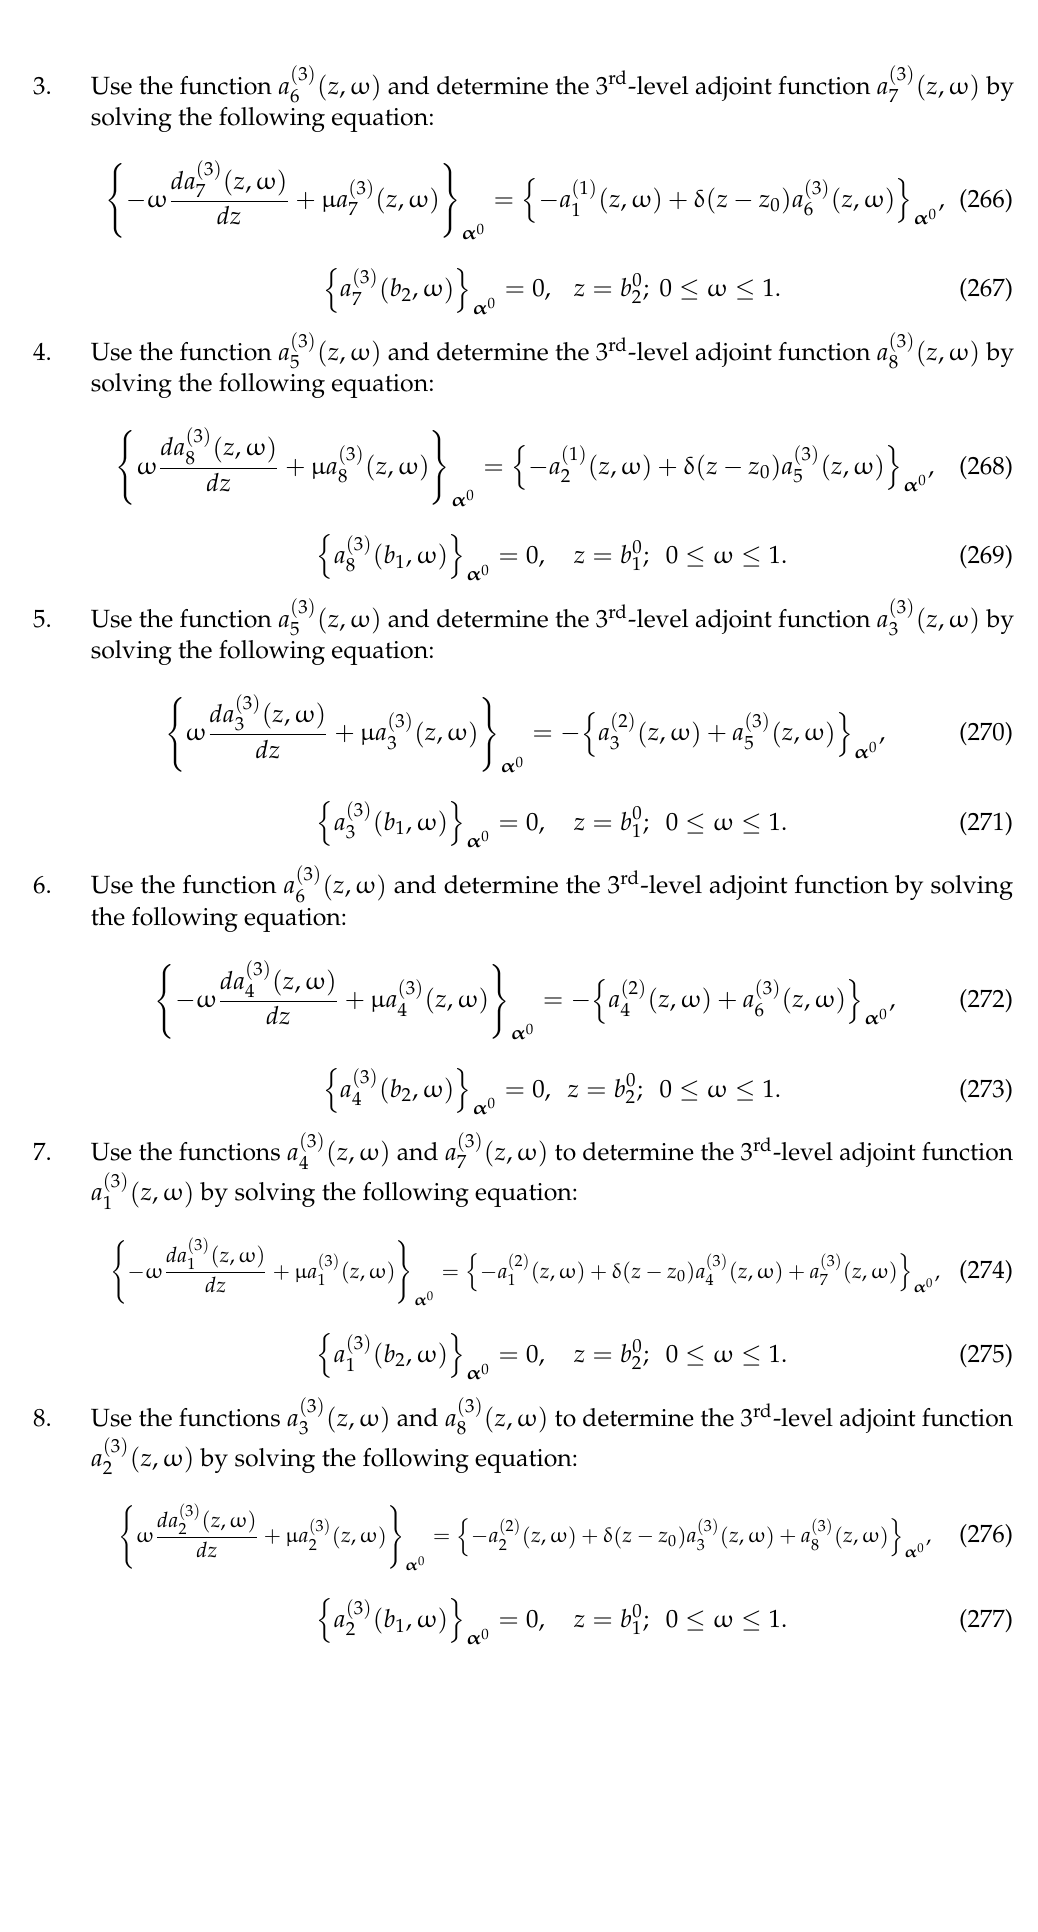
3. Use the function a